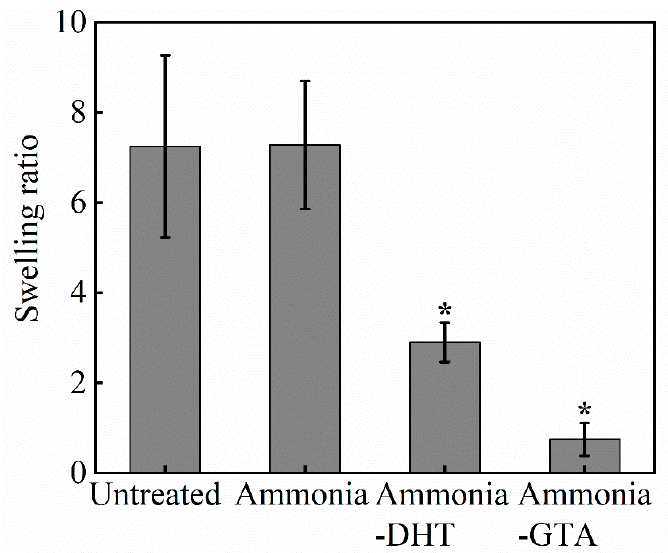
Figure 7. Swelling ratio of collagen tubes before and after various treatments. * p < 0.05, crosslinked collagen tubes are significantly different from untreated collagen tube.